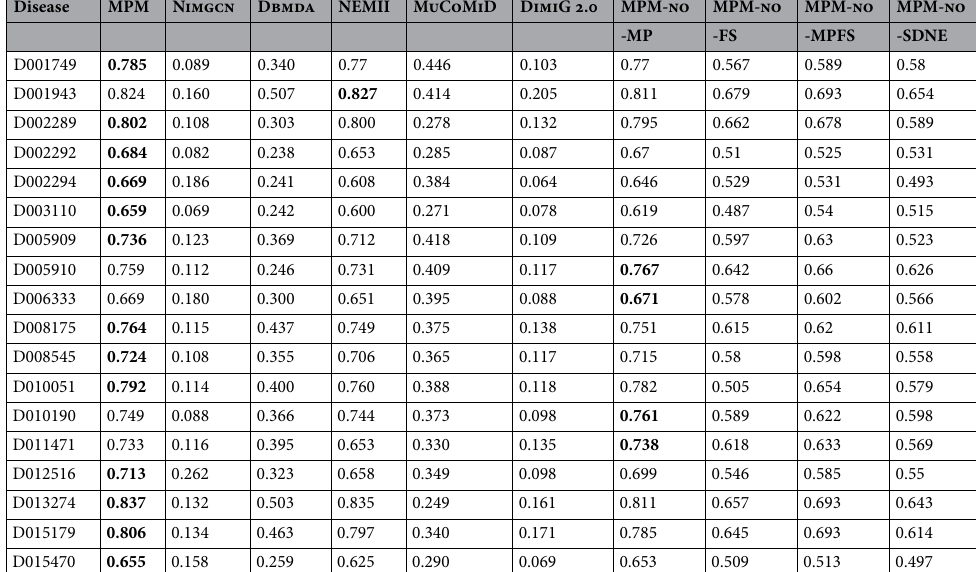
Table 3. The AP scores corresponding to the 18 complete test sets for new diseases average over 20 experimental runs.